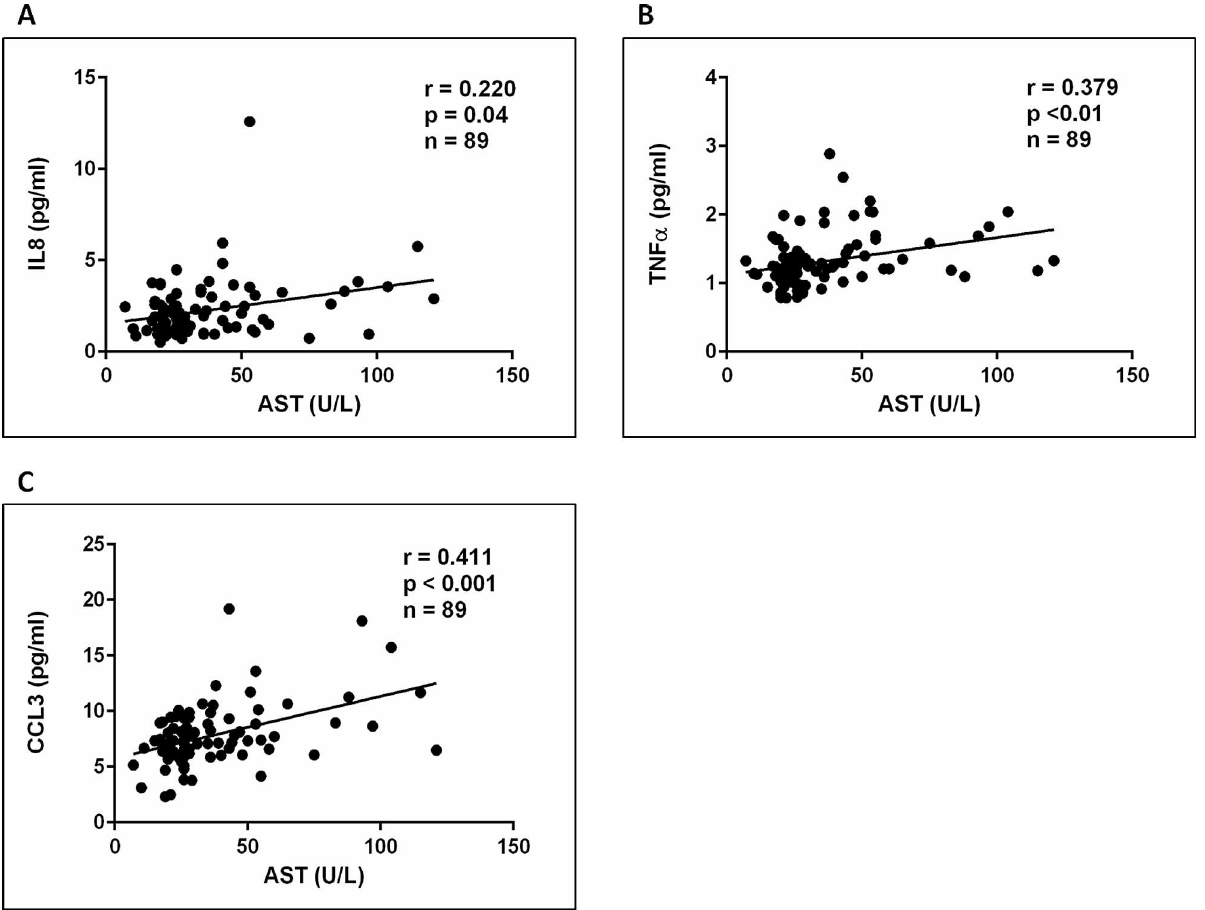
Fig 5. Pro-inflammatory cytokines correlate AST levels. Using Spearman correlationanalysiswe detected a significantly, positive correlation between plasma AST levels and cytokines IL8, TNF α and the chemokineCCL3 (Fig 5A-5C).